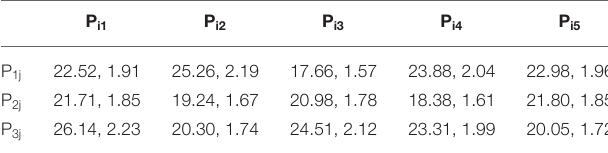
TABLE 2 | The elastic modulus (GPa) and peak loads (N) of nanoindentation